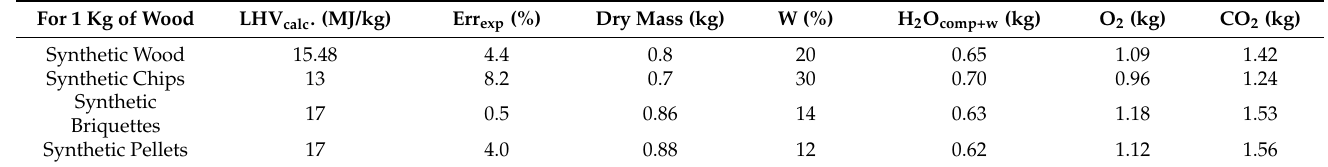
Table 7. Calculated data: LHV, amount of water, CO 2 and O